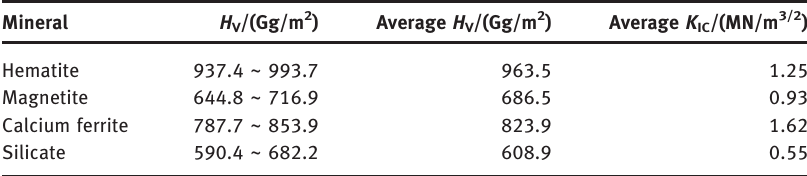
Table 4: Indices of micromechanical properties of traditional sinter. Mineral H V /(Gg/m  ) Average H V /(Gg/m  ) Average K IC /(MN/m  /  ) Hematite  .  ~  .   .   .  Magnetite  .  ~  .   .   .  Calcium ferrite  .  ~  .   .   .  Silicate  .  ~  .   .   .